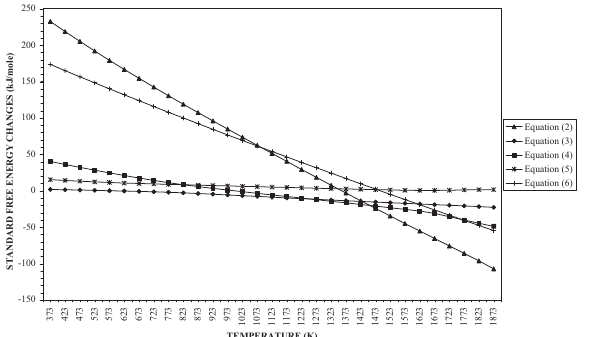
Figure 3. Standard free energy changes for the reduction of zinc and iron species by hydrogen in the temperature range of 373 to 1.873 K (100 to 1600 ı